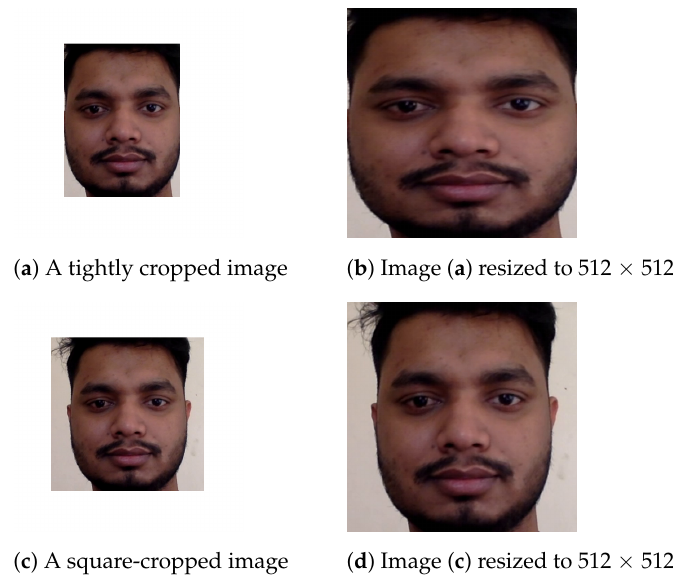
Figure 3. Representations of images using the two methods of cropping and their respective trans- formed image after resizing for model input. Image ( a ) demonstrates a tightly cropped image using the bounding boxes of RetinaFace [44], and ( b ) shows a sample where the bounding boxes of ( a ) were expanded to make a squared